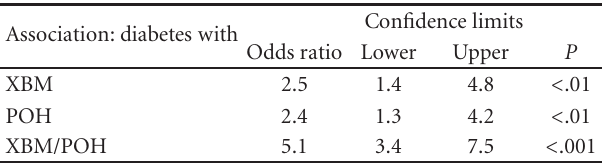
Table 3: Odds ratios of associations between diabetes excess body mass (XBM), poor oral health (POH), and the combination of the latter two